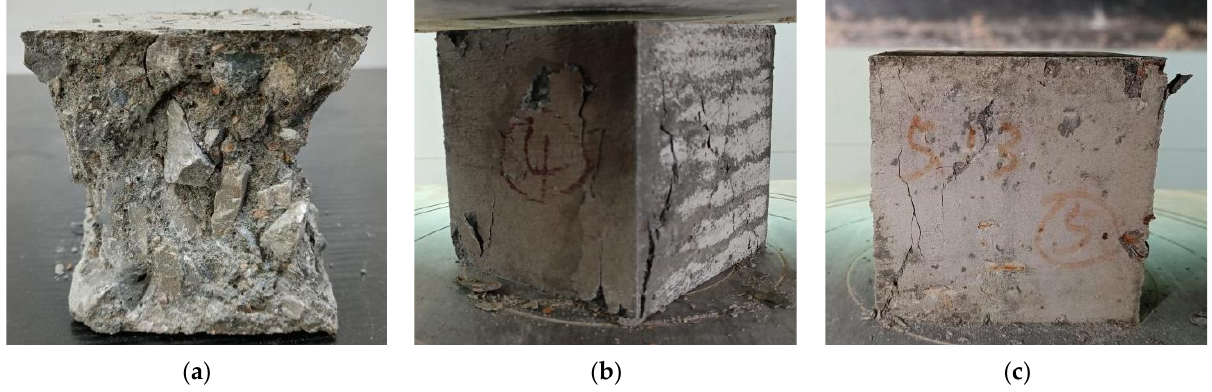
Figure 9. Failure modes in cubic compressive tests : ( a ) v sf = 0%; ( b ) v sf = 1%; ( c ) v sf = 2%.